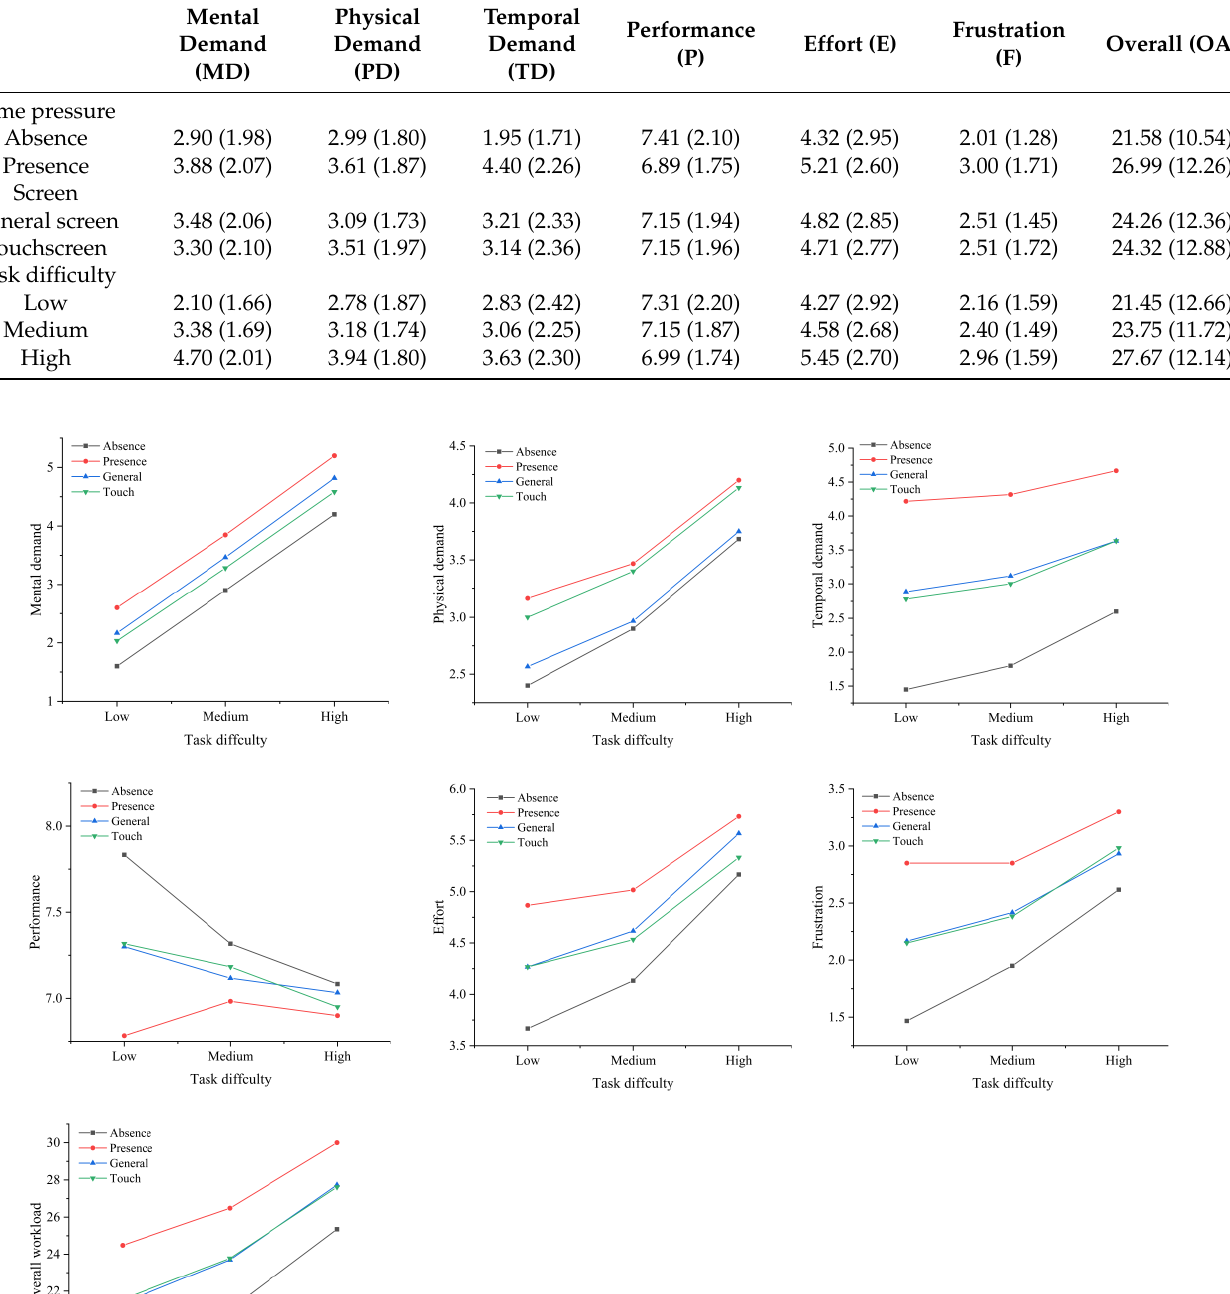
Table 2. Mean (SD) of the perceived workload by time pressure, screen type, and task difficulty.